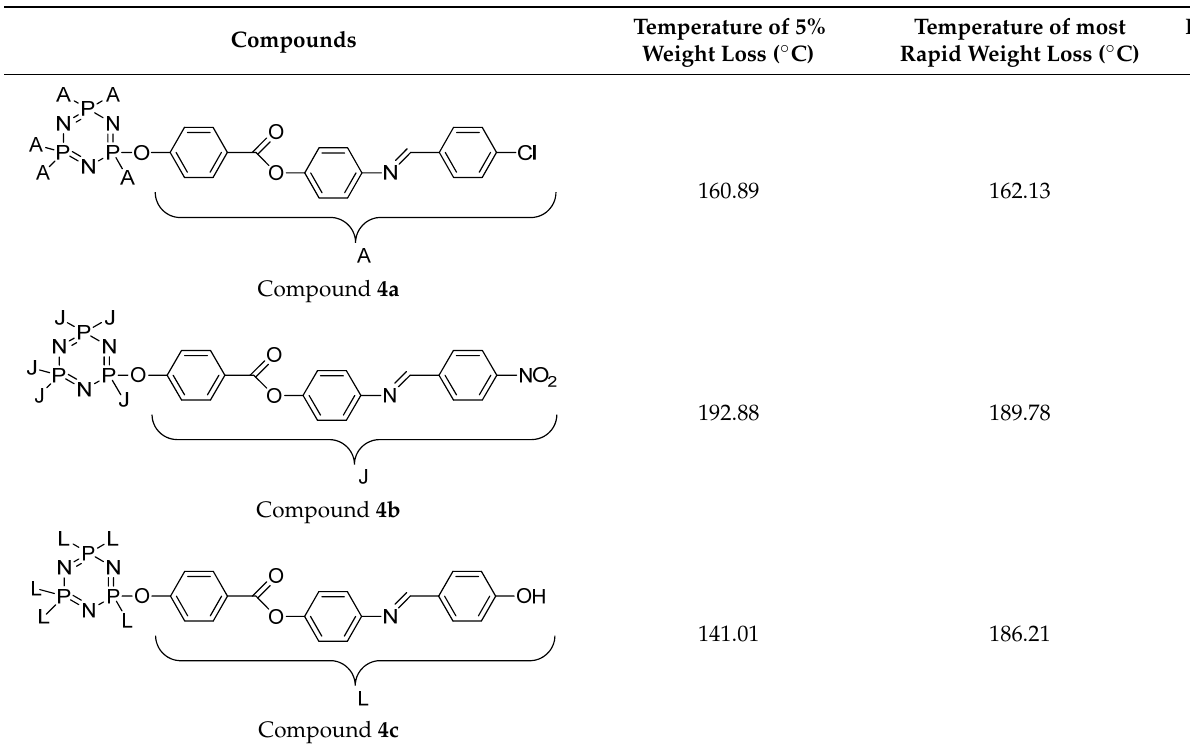
Table 2. Thermal properties of final compounds, 4a – c .